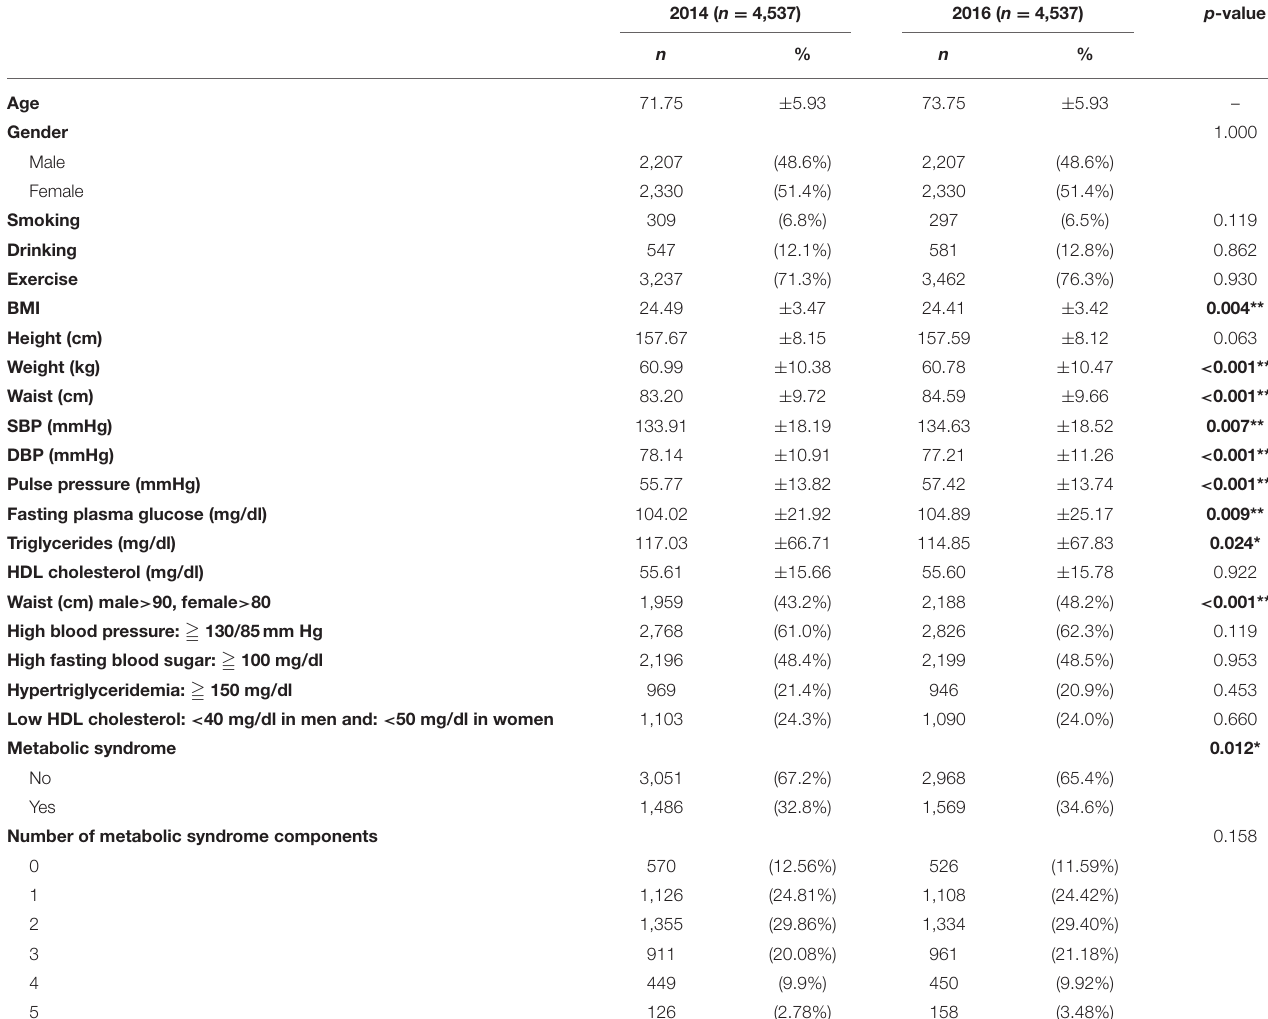
TABLE 1 | Demographic data of study participants in 2014 and